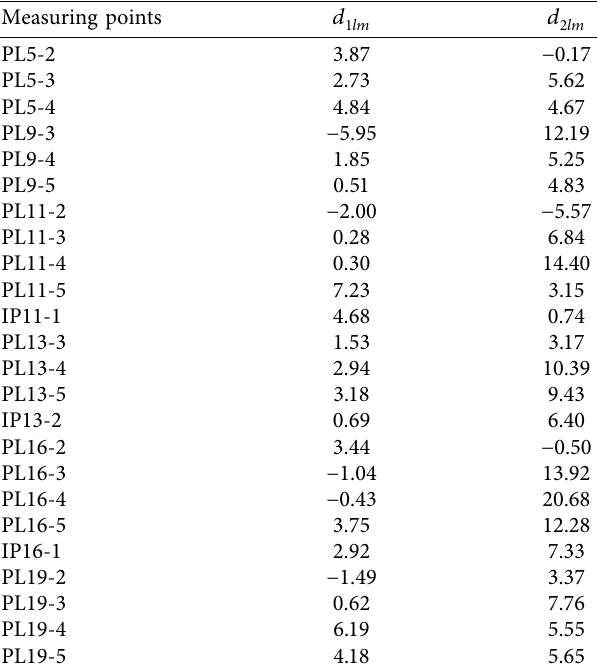
and d in the aging component. 1 lm 2 lm